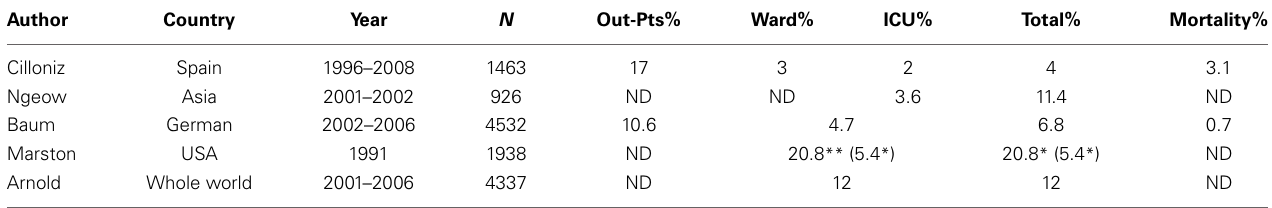
Table 1 | Prevalence of Mycoplasma pneumoniae pneumonia in CAP.